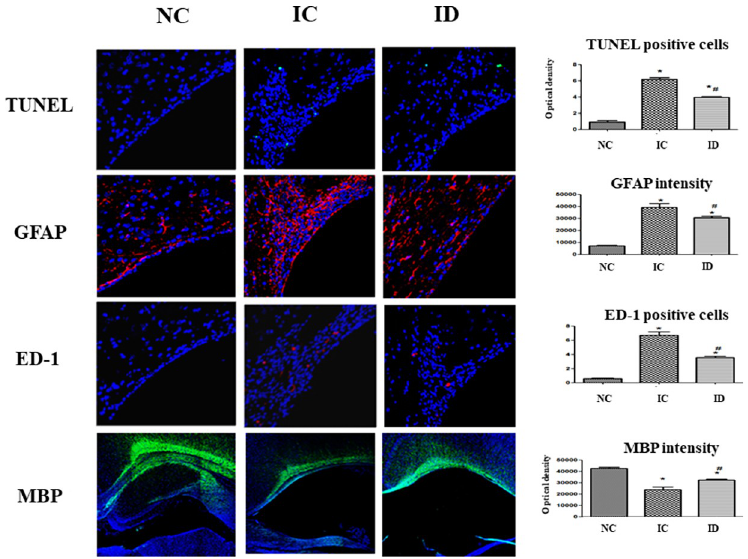
Fig 5. Cell death and reactive gliosis induced by severe IVH showed a decrease after dexamethasone treatment. Representative immunofluorescence photomicrographs of the periventricular area with staining for terminal deoxynucleotidyl transferase nick-end labeling (TUNEL, green), glial fibrillary acidic protein (GFAP, red), ED-1 (red), and myelin basic protein (MBP, green, original magnification × 400; scale bars = 25 μ m). The average number of TUNEL-positive cells, the average density of GFAP staining, the average number of ED-1-positive cells, and the average MBP density in the periventricular area are shown. The numbers are expressed as the mean ± SEM. IVH refers to intraventricular hemorrhage. � P < .05 compared to the normal control (NC, n = 4) group, # P < .05 compared to the IVH control (IC, n = 5). ID, IVH + dexamethasone (n = 6).